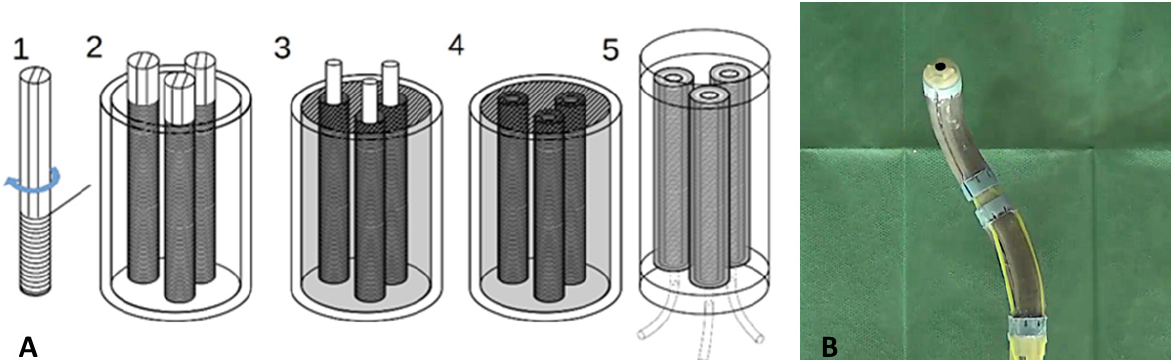
Figure 3. ( A ) Schematic showing the fabrication stages for a STIFF-FLOP arm segment made of fibre-reinforced pneumatic chambers in a cylindrical silicone structure [28], ( B ) STIFF-FLOP robot arm prototype comprising two segments and a camera integrated at the tip.